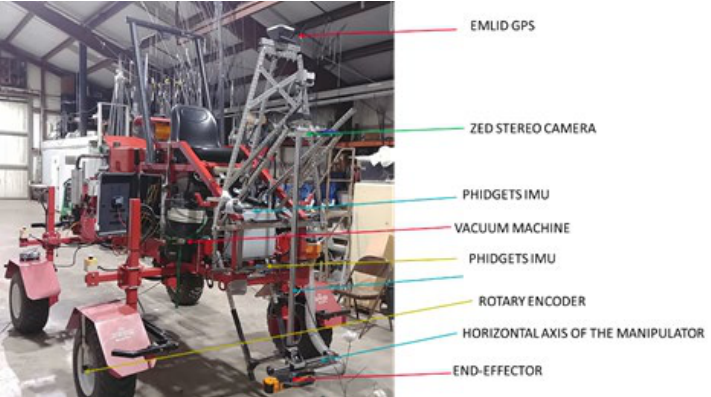
Figure 3. Red rover platform for testing cotton harvesting system [74]. Adapted from Fue, Porter, Barnes, Li and Rains (2020).